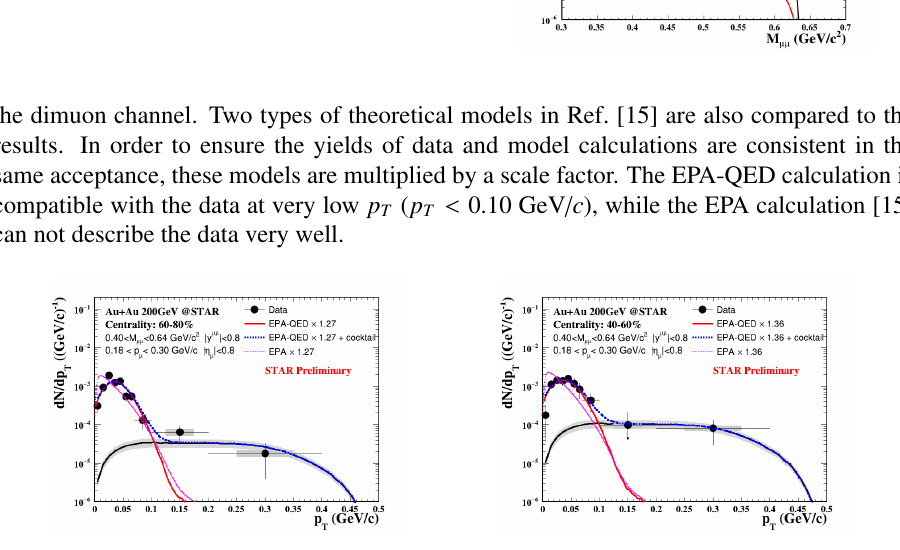
Figure 2: (color online) The µ + µ − excess mass spectra (data - cocktail) in Au + Au col- = 200 GeV for pair p lisions at √ s NN 0 . 10 GeV / c in di ff erent centrality bins com- pared to the model calculations.